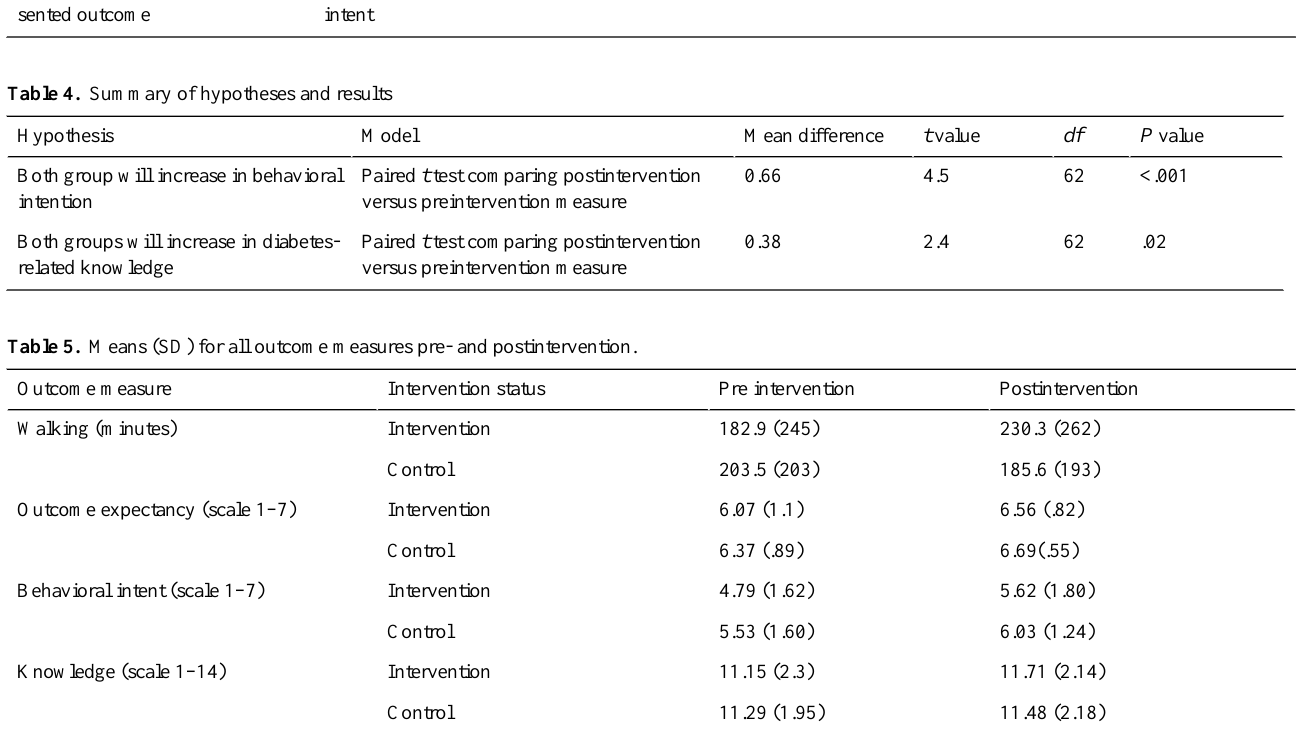
Table 4. Summary of hypotheses and results